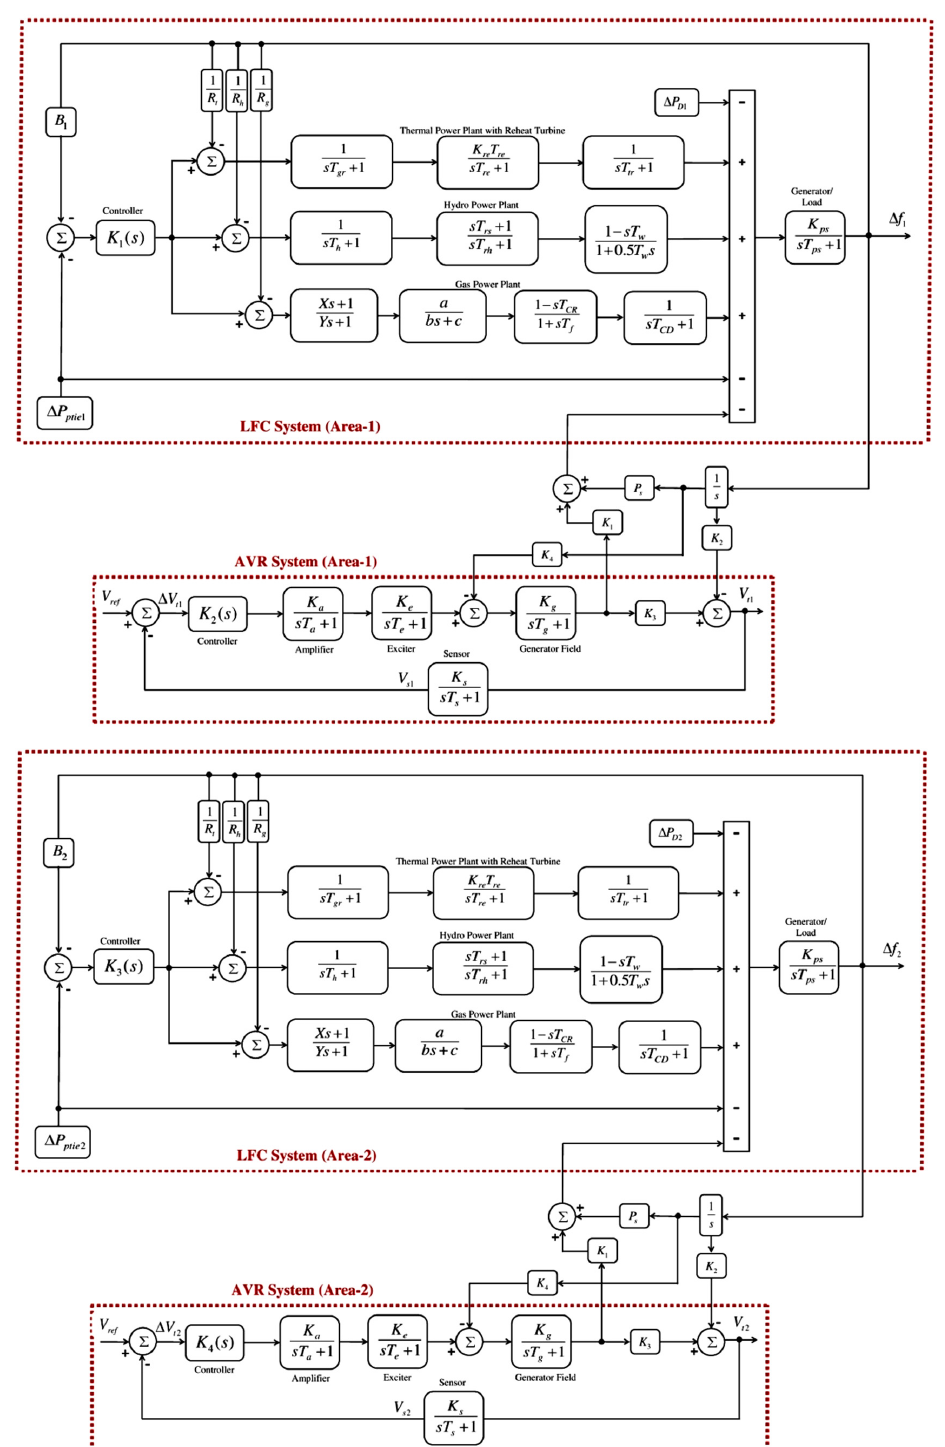
Figure 5. Two-area multi-source IPS.